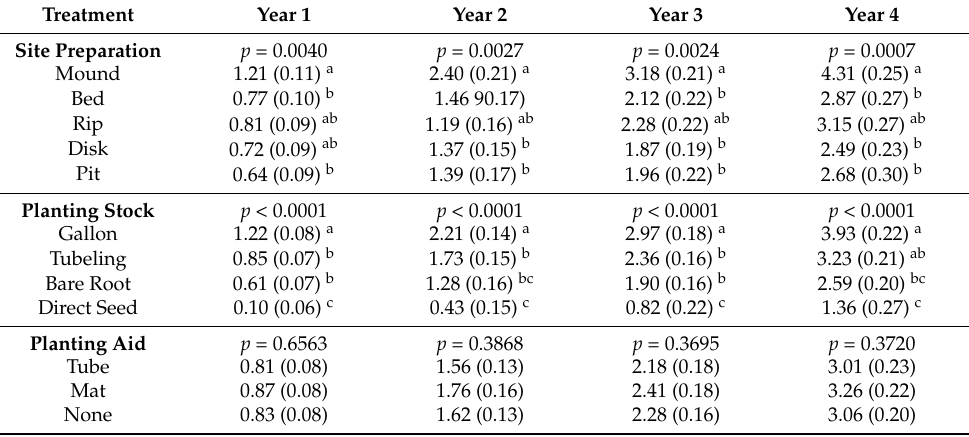
Table 4. Average dbh (cm) (SE) for American sycamore in the Virginia Piedmont by site preparation, planting stock type, and planting aid. Values with different letters indicate statistically significant differences according to Tukey’s post hoc HSD ( p < 0.05). Bolded text indicates treatment